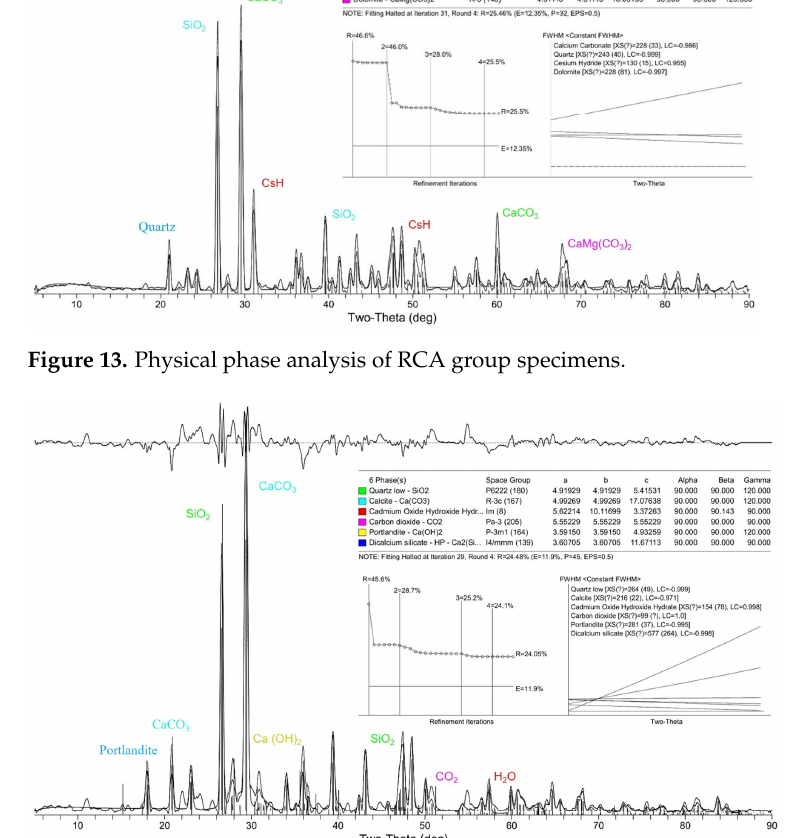
Table 6. Comparison between calculated and tested values of water flux of repaired 14-day speci- mens/(L/h).